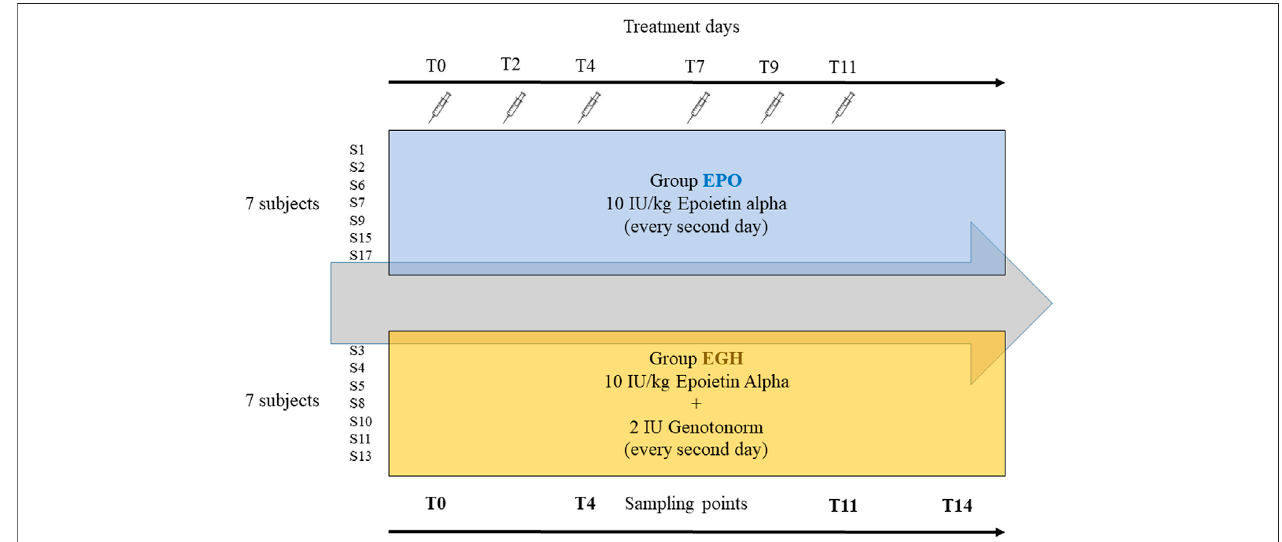
FIGURE 1 | The design of the